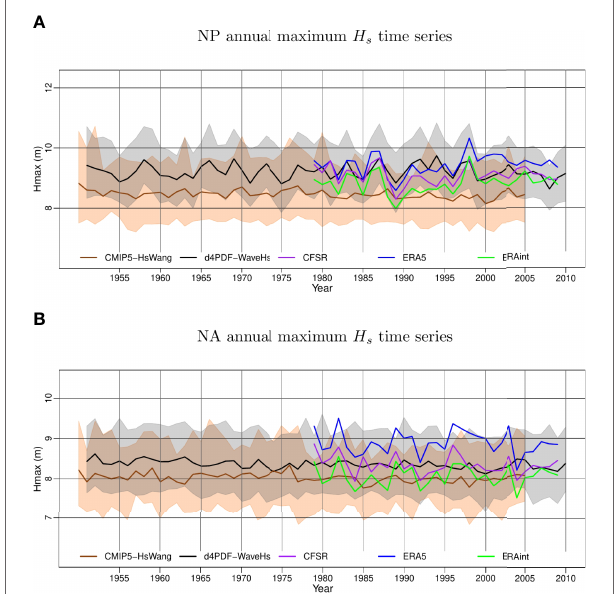
FIGURE 5 | NP (A) and NA (B) time series of the annual maximum H s , in m, as derived from d4PDF-WaveHs (black), CMIP5-HsWang (brown), CFSR (purple), ERA5 (blue), ERAint (green). For the d4PDF-WaveHs and CMIP5- HsWang ensembles we show the ensemble mean (thick lines) and the range between the 2.5% and 97.5% percentiles (shaded